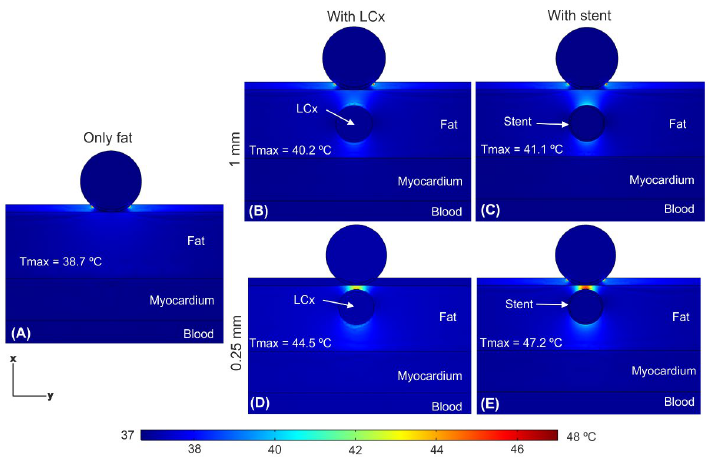
Figure 6. Temperature distributions just after applying a pulse train with an interval between pulses of 100 μs comparing different conditions: epicardial fat layer without artery ( A ), artery at 1 mm from the ablation device without ( B ) and with ( C ) metal stent, and artery at 0.25 mm without ( D ) and with ( E ) with metal stent.